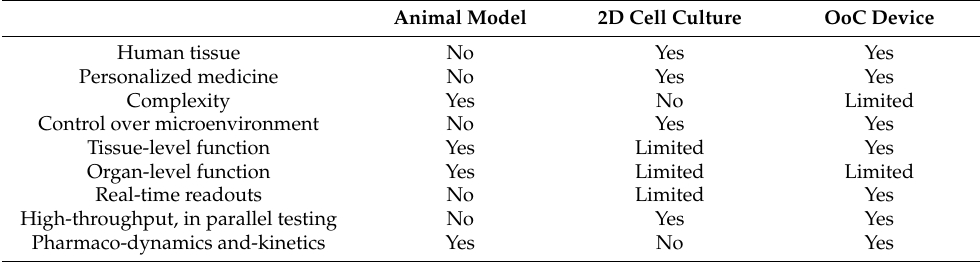
Table 2. Comparison of existing preclinical research models and OoC devices. Animal Model 2D Cell Culture Human